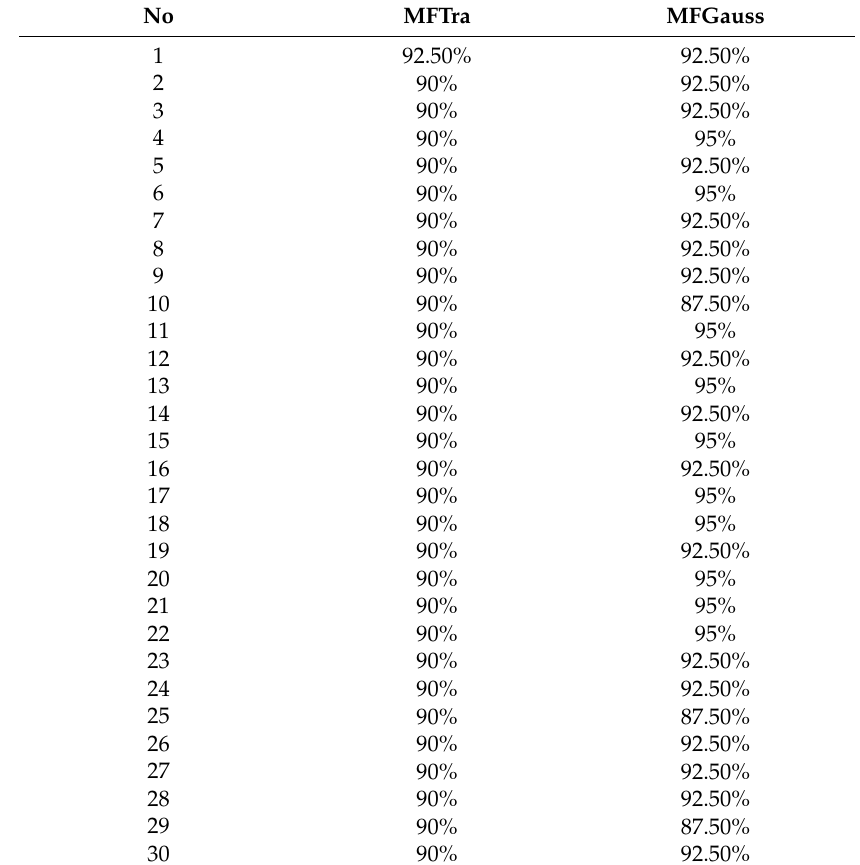
Table 10. Percentage of classification in each experiment with CSA.